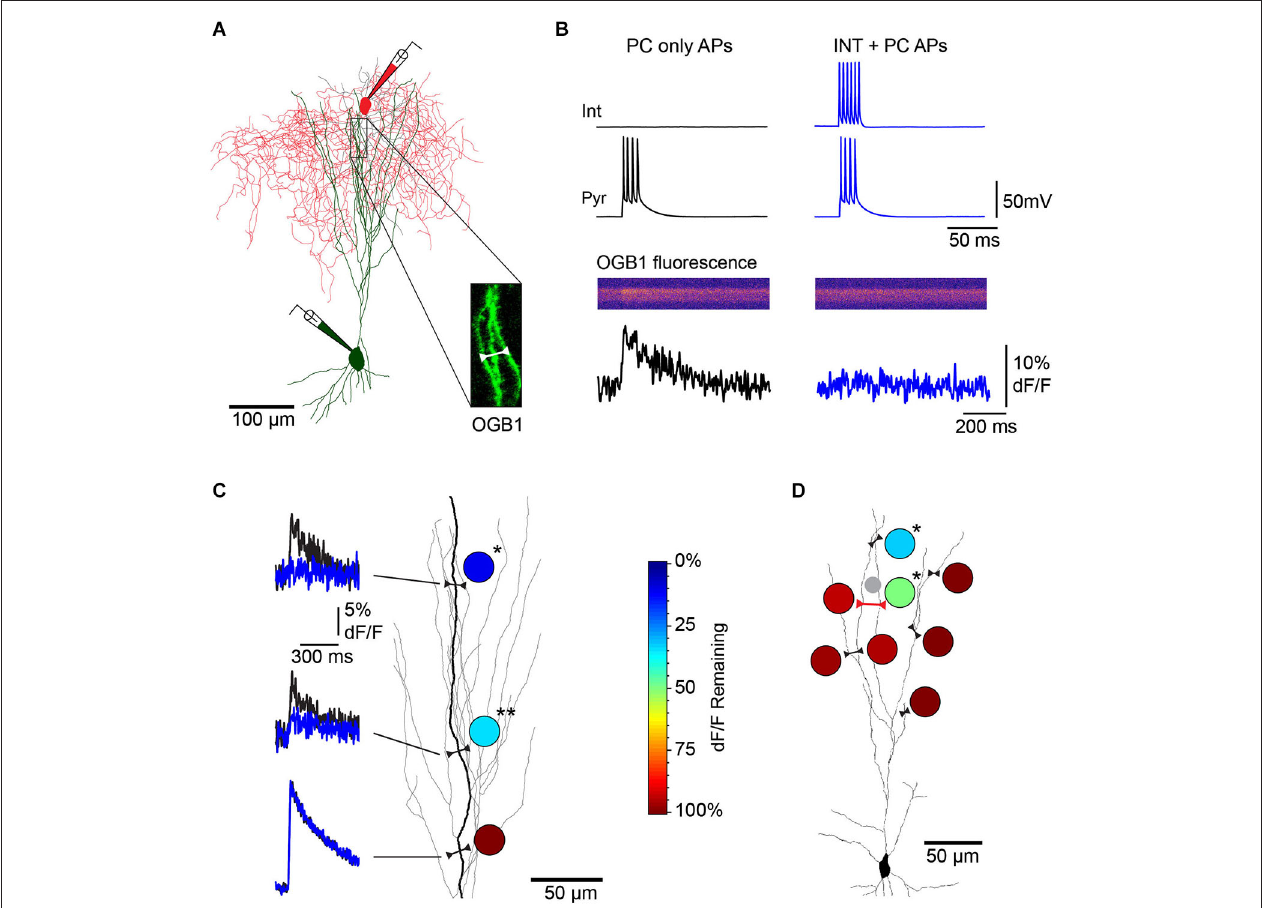
location-dependent suppression of bAP-evoked Ca 2 + responses. Left, dF/F elicited by PC only APs (black) overlaid with dF/F elicited by INT+PC APs (blue). Circles, heat map of dendritic inhibition plotted as percent of control dF/F remaining during INT co-activation at each of the three imaging sites. (* p = 0.0103, ** p = 0.0066; n = 4 trials/condition). Color scale on right applies to all other panels. (D) Multiple line scans over different dendritic branches of the same PC show branch-specific inhibition. Single line scan including two neighboring branches (red line) confirmed branch-specific modulation of Ca 2 + transients during the same trials. (* p = 0.0414 (proximal site), p = 0.0206 (distal site); n = 3 trials/condition). The small gray circle represents the location of the L1 INT